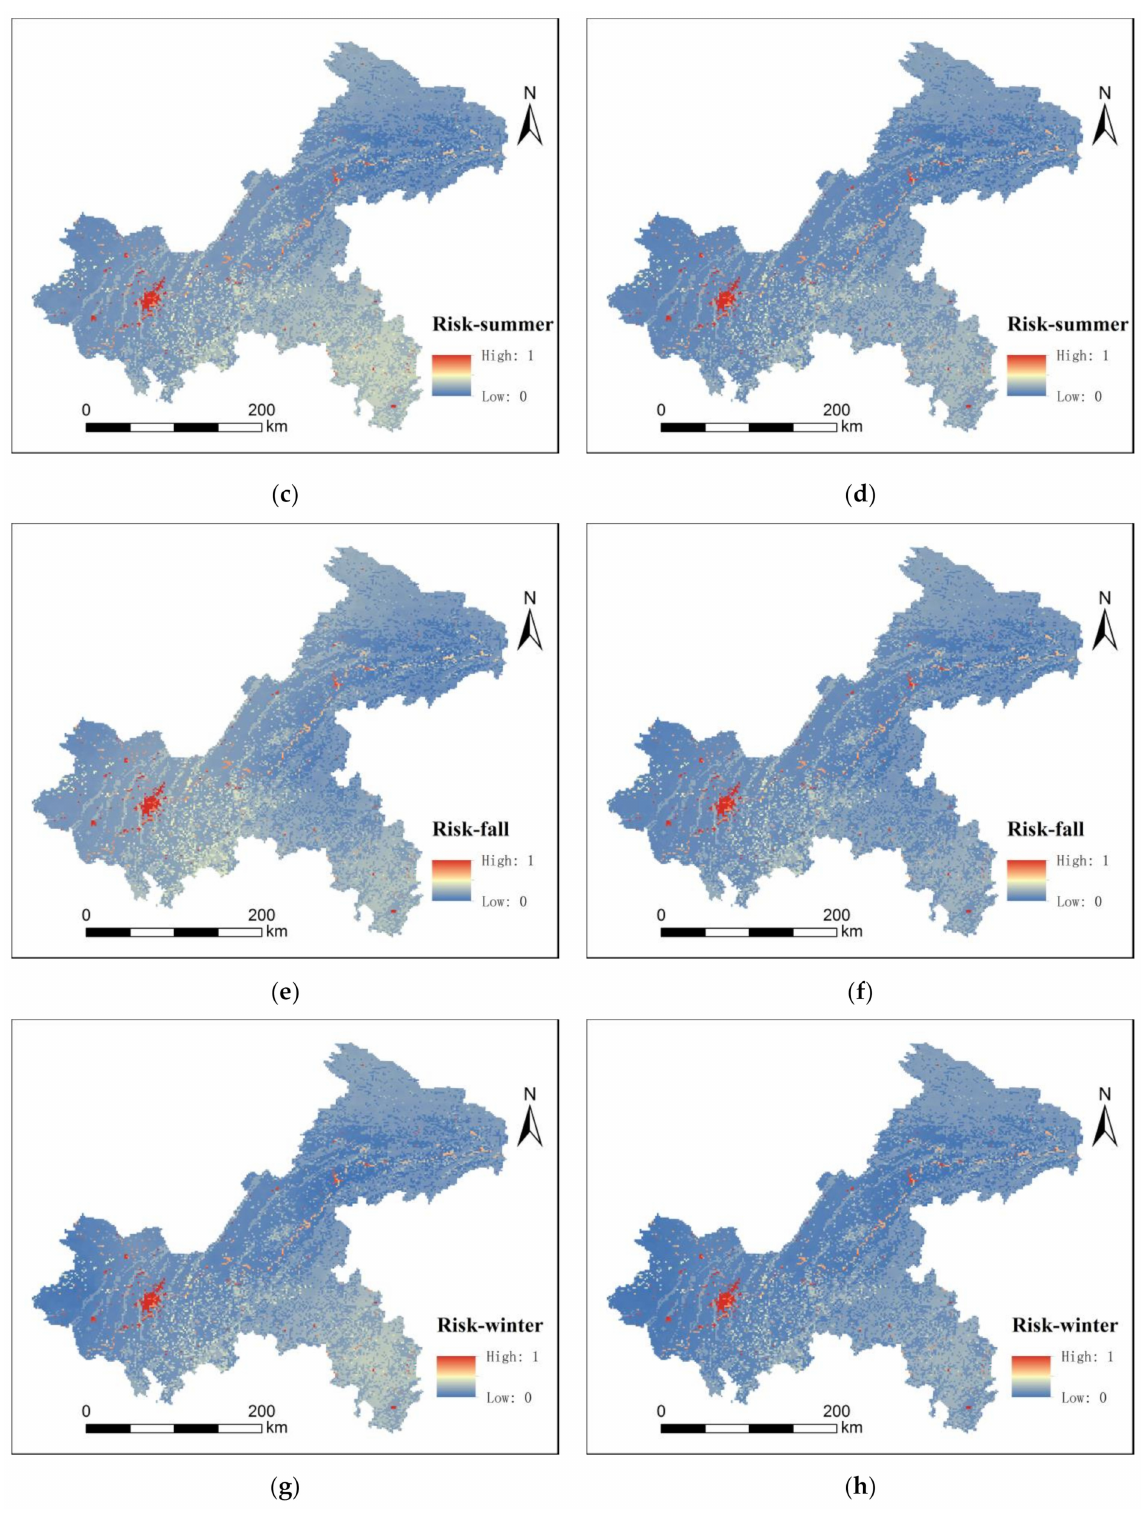
Figure 10. Spatial distribution of the flood risk in four seasons of Chongqing: ( a ) flood risk in spring—AHP, ( b ) flood risk in spring—TFN-AHP, ( c ) flood risk in summer—AHP, ( d ) flood risk in summer—TFN-AHP, ( e ) flood risk in fall—AHP, ( f ) flood risk in fall—TFN-AHP, ( g ) flood risk in winter—AHP, ( h ) flood risk in